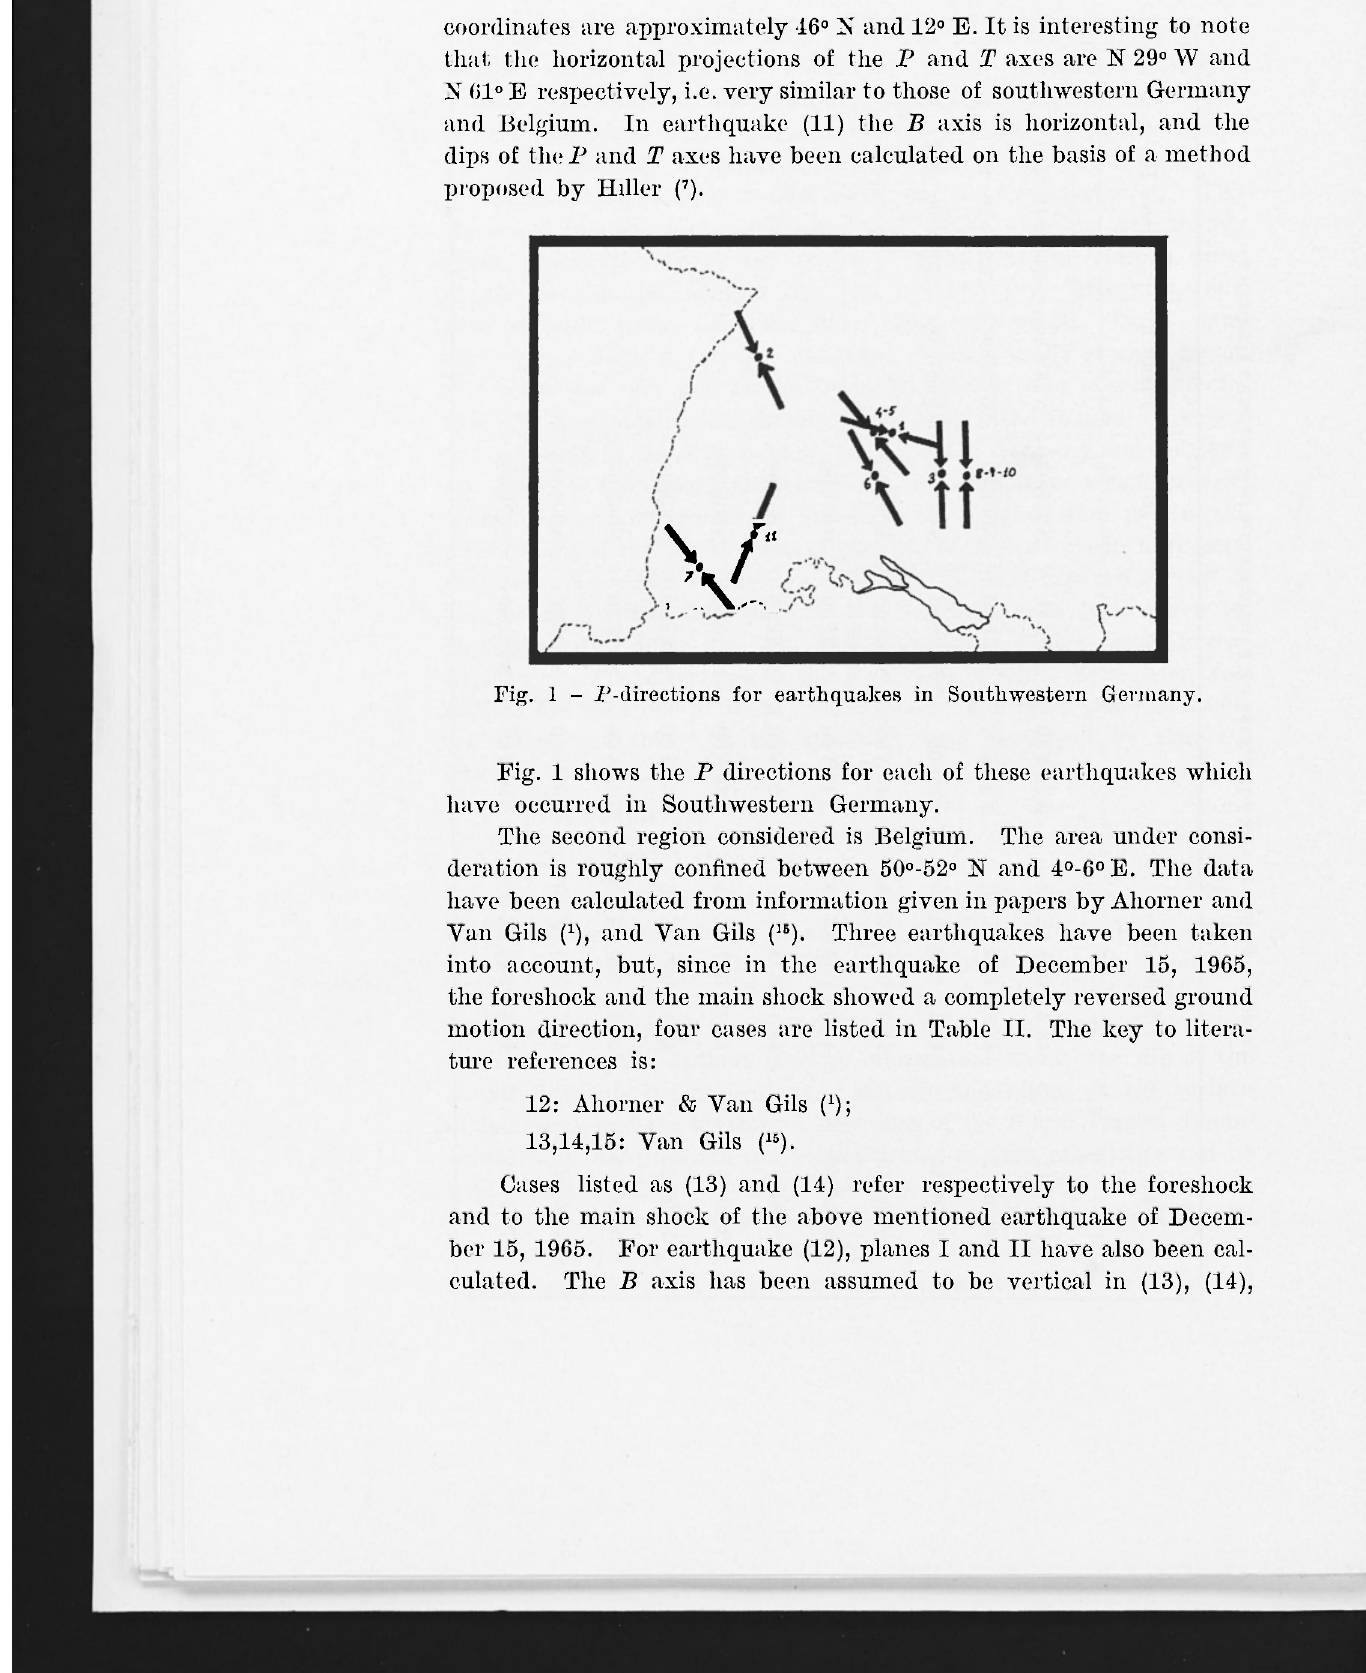
Fig. 1 - P-directions for earthquakes in Southwestern Germany.